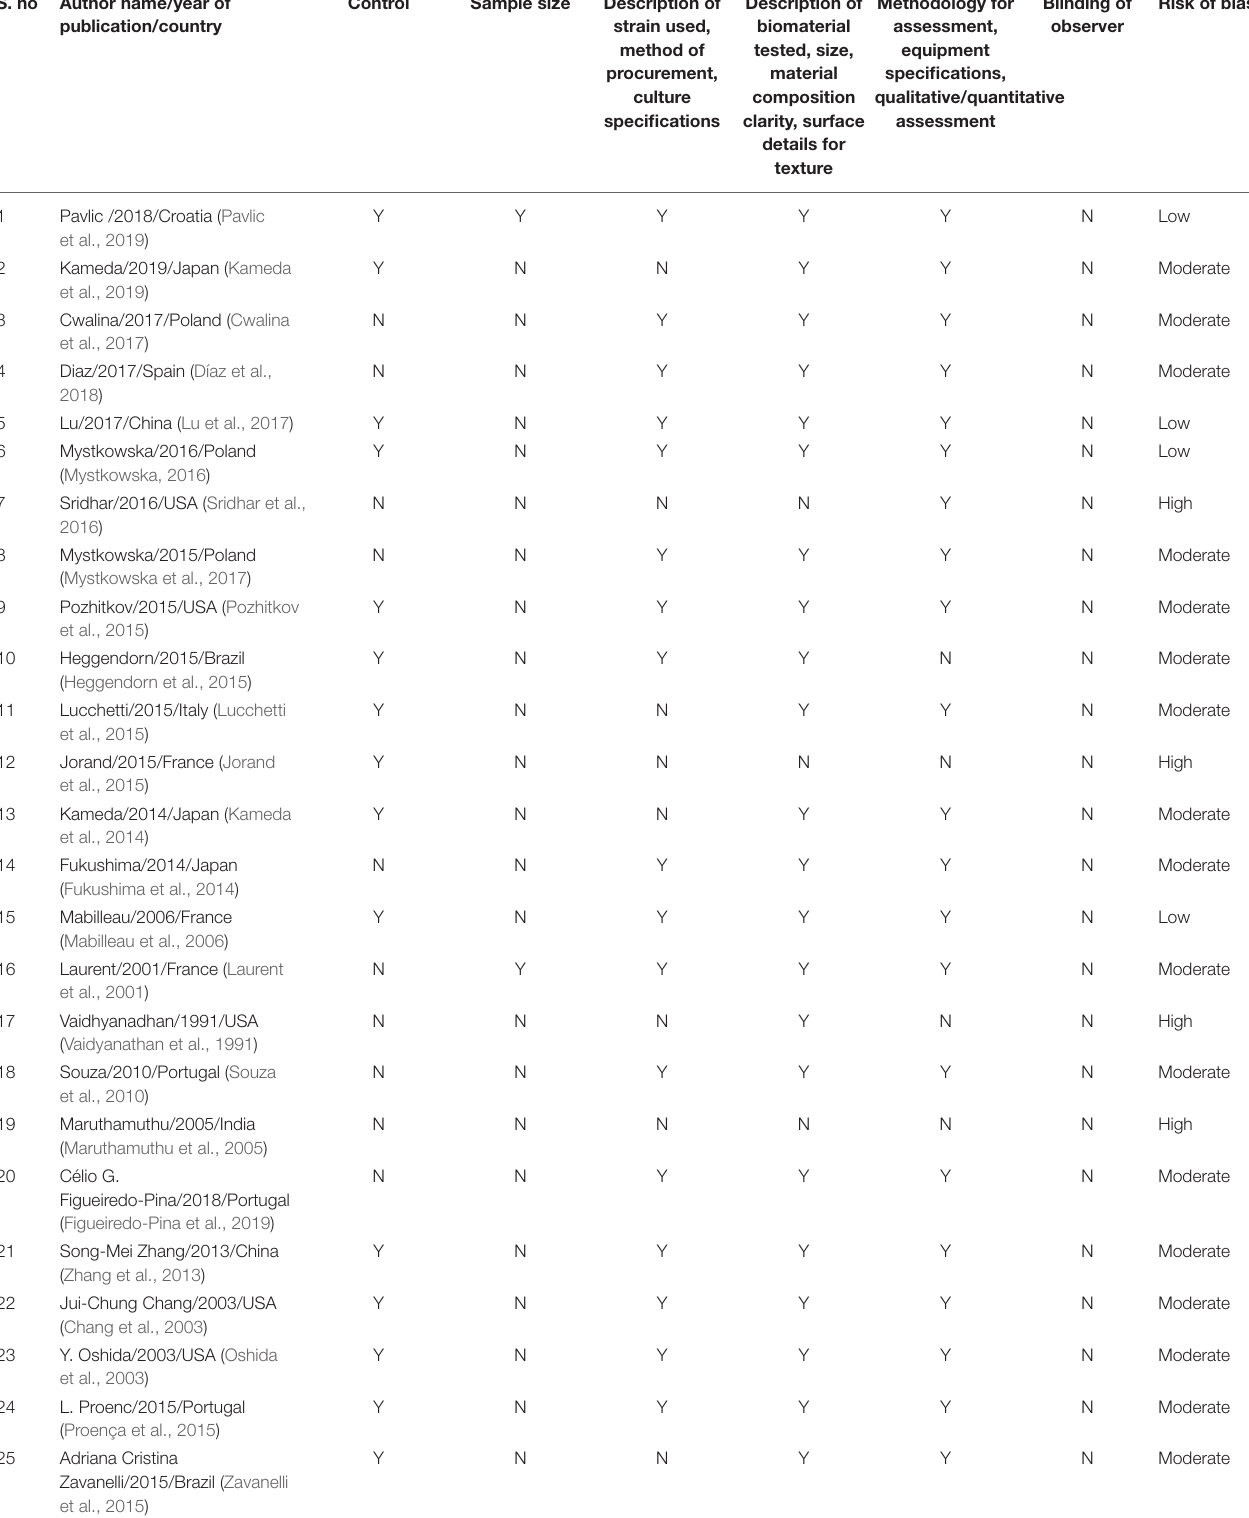
TABLE 2 | Summary of the risk of bias assessment of the studies included in the systematic review.